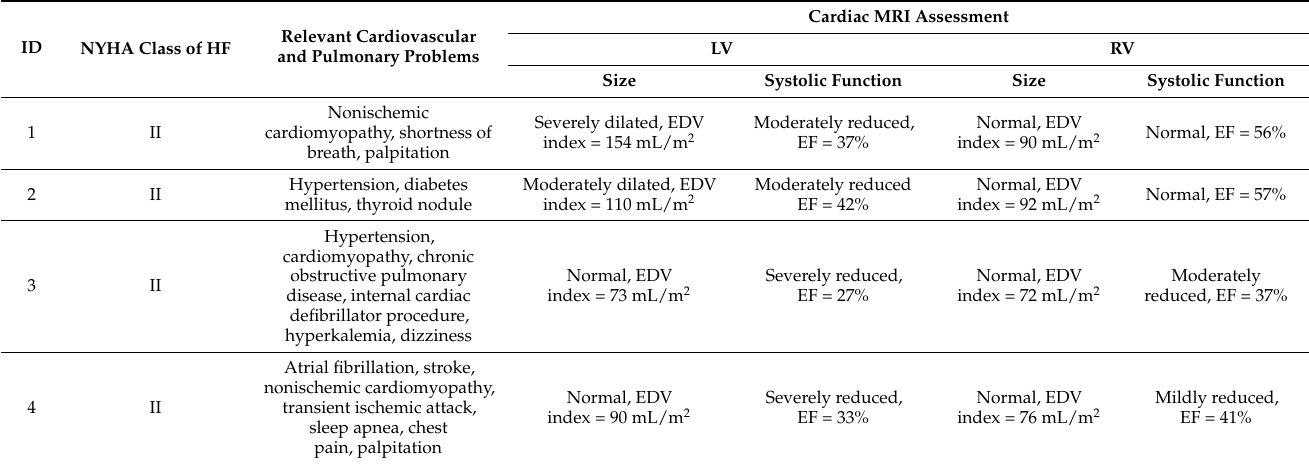
Table 1. NYHA classification, diagnosed diseases and cardiac MRI assessment of the HF patients with EF <